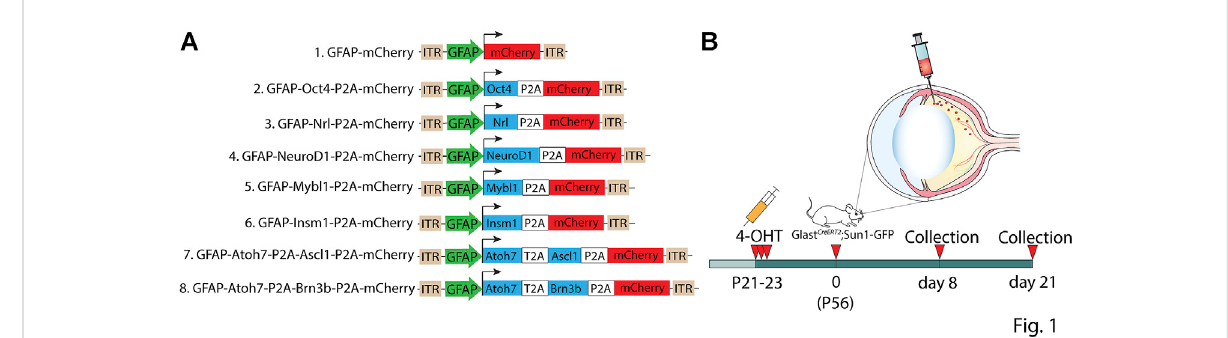
FIGURE 1 Summary of constructs tested in the study. (A) Schematic of the GFAP AAV constructs and (B) the work fl ow: three weeks old GlastCreERT2; Sun1-GFP micewereinducedwith3dailydosesof4-OHTdeliveredintraperitoneally,intravitreallyinjectedwithGFAPAAVconstructsat2 monthsof age, and collected 8 days and 21 days following AAV infection for